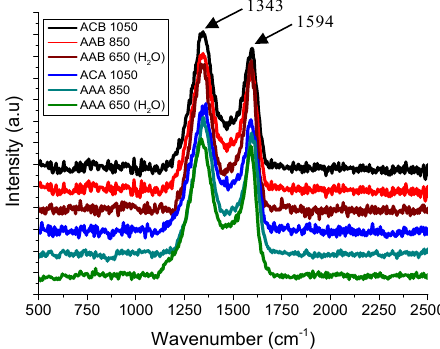
Figure 3. Raman spectra of prepared aerogels.